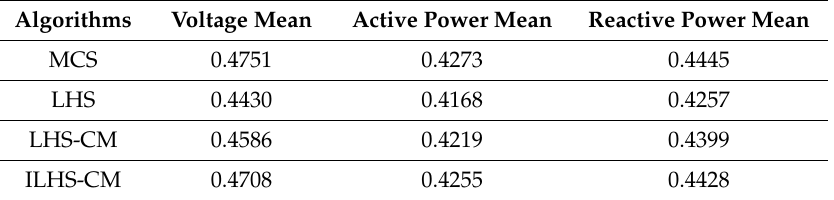
Table 4. Comparison of the means of four